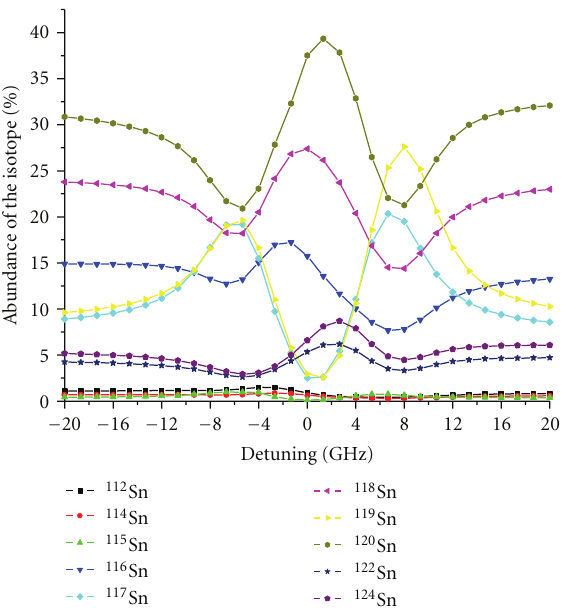
Figure 5: Experimental abundance of the tin isotopes as a function of laserdetuning for the 286.3317nm transitionfor a laser linewidth of 1200MHz and a residual Doppler width of 400MHz.